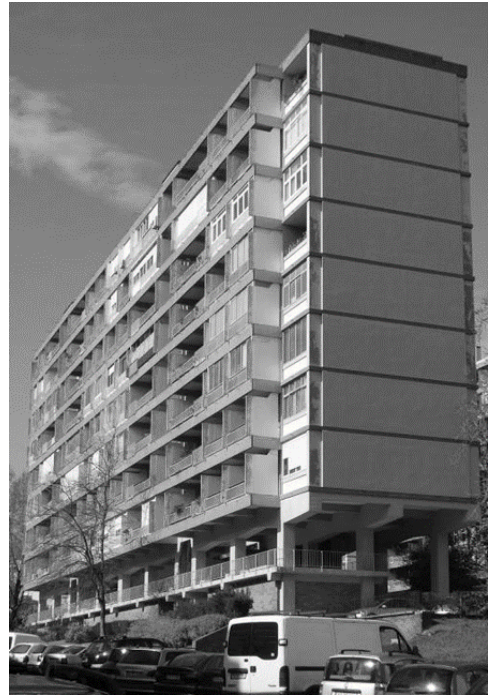
Figure 8. Main façade.